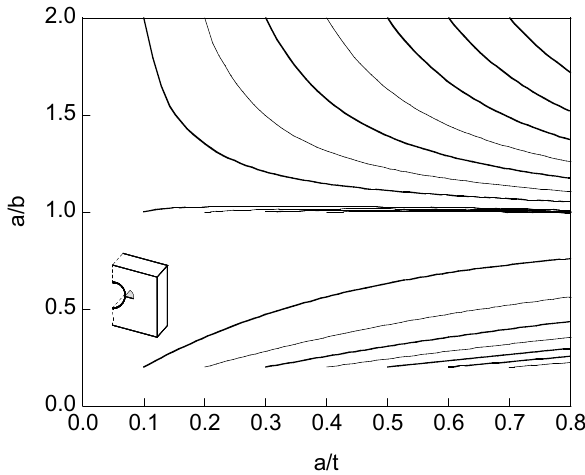
Figure 7. Crack aspect ratio evolution during corrosion fatigue propagation for cracks emanating from a hole with r = 2 t .